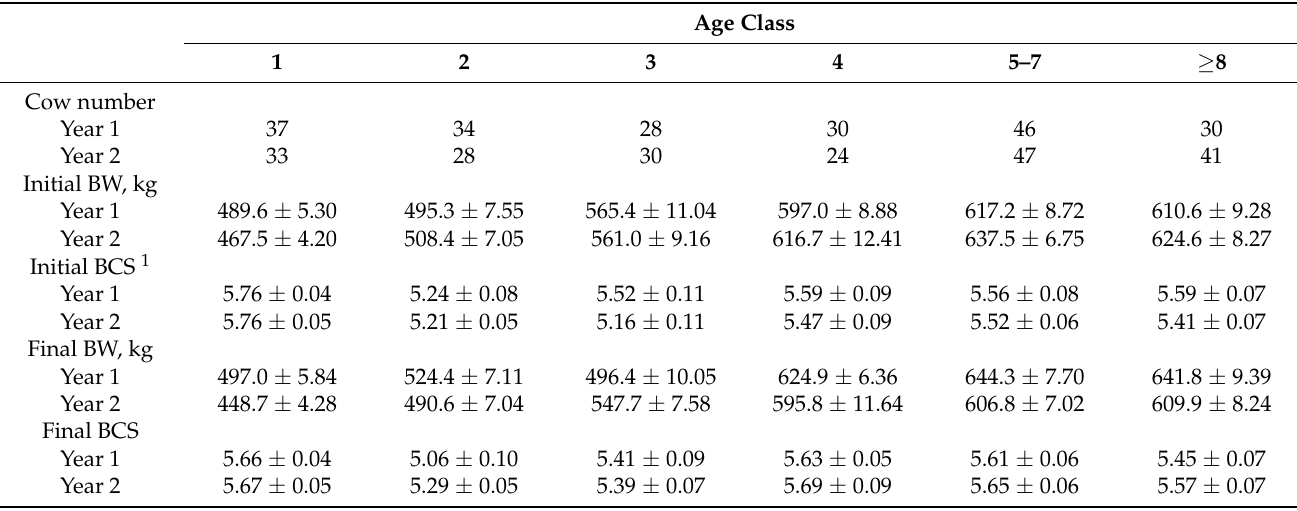
Table 2. Initial body weight (BW) and body condition score (BCS) for 6 age classes of cattle ( ± SE) across a 2-year grazing trial (2018/2019 and 2019/2020) at the Northern Agricultural Research Center Thackeray Ranch, Havre, MT,